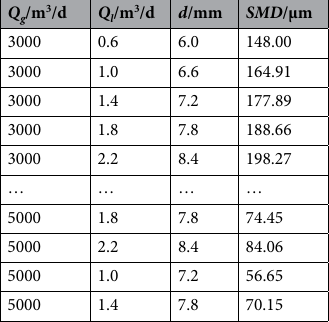
Table 3. Experimental parameters and results.